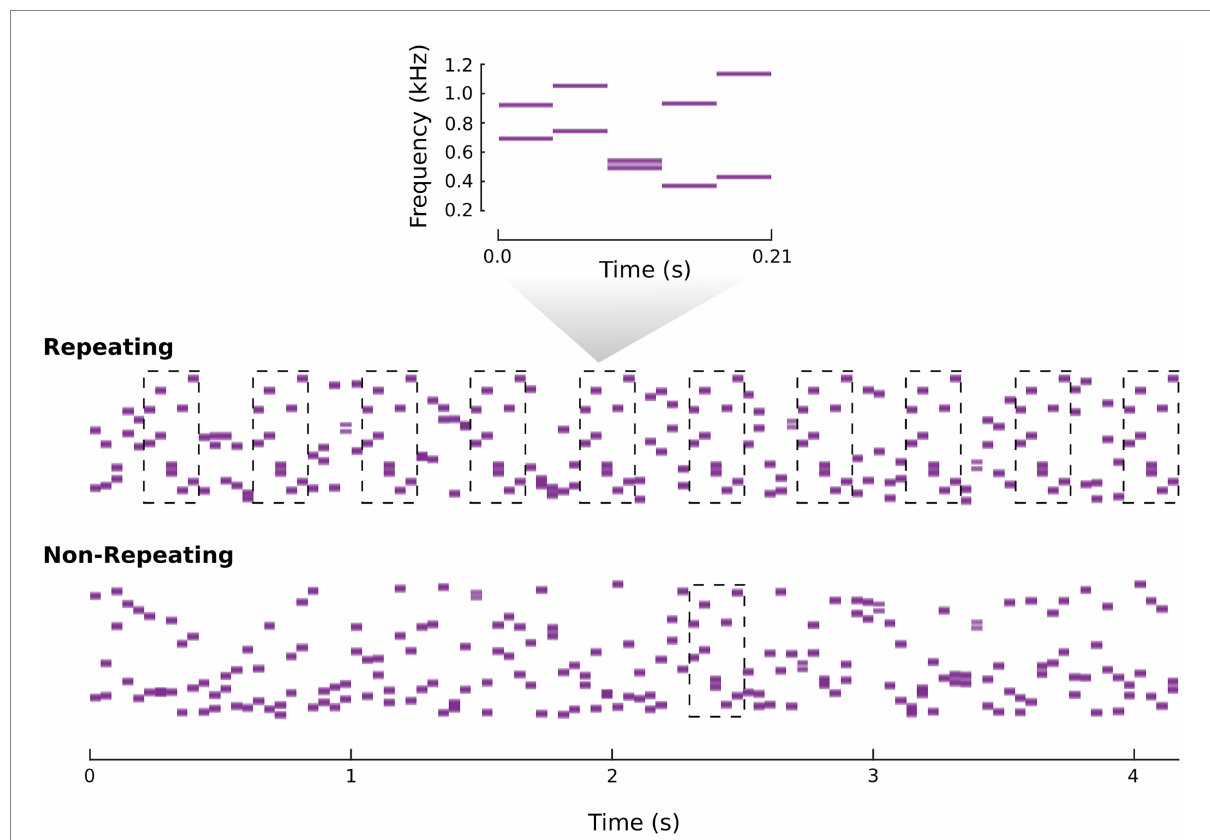
FIGURE 1 Spectrogram example of repeating and non-repeating excerpts of synchronous tone trains. The breakout spectrogram shows an example pattern made up of 5 randomly generated multitone complexes. The dashed boxes in the repeating and non-repeating excerpts mark the presentation of that